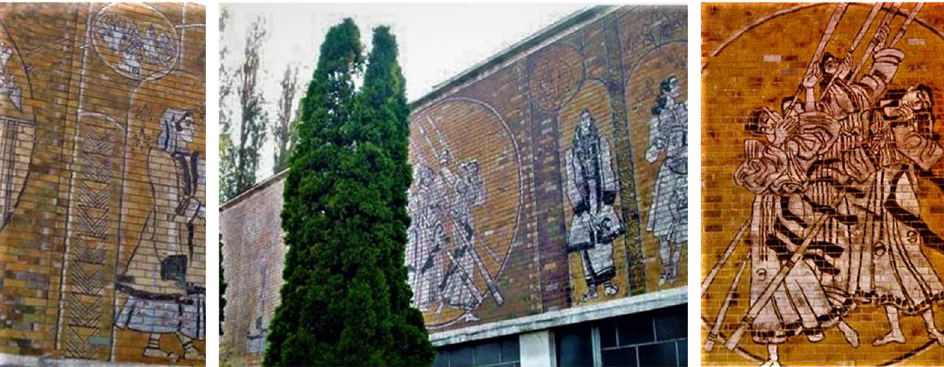
Figure 7. The mosaic “The heroism of the working class in the endeavor of socialist industrialization”